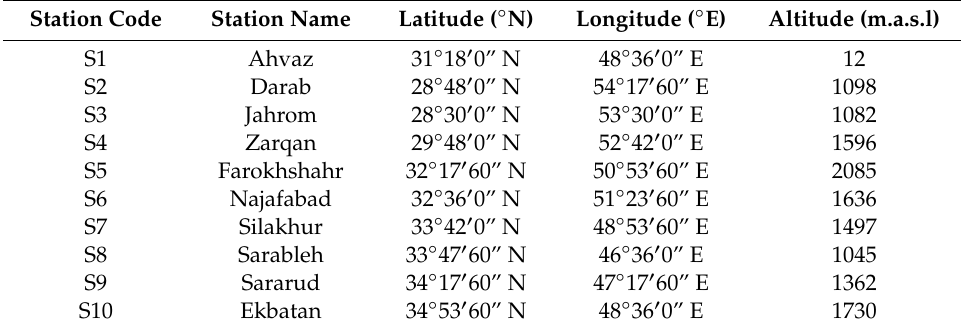
Table 1. Geographical coordinates of agrometeorological